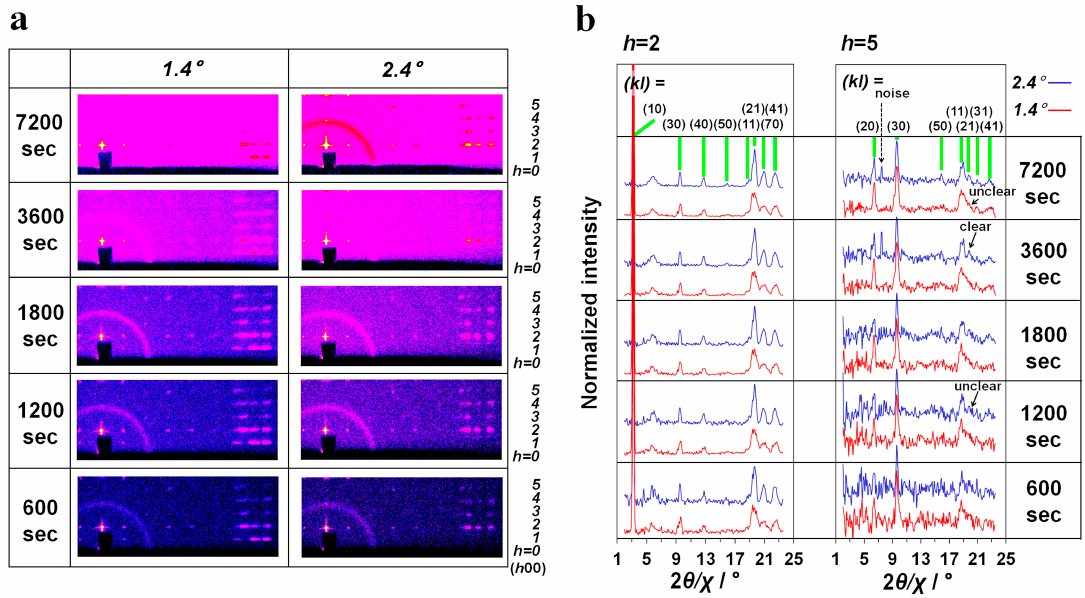
Figure 5. ( a ) GIXD images obtained for 640-nm-thick MO β Gal hemihydrate crystalline films with incident angles of 1.4 ◦ and 2.4 ◦ and different radiation times. ( b ) One-dimensional profiles corresponding to the (2 kl ) and (5 kl ) reflection planes derived by cutting the equatorial line in the GIXD image.